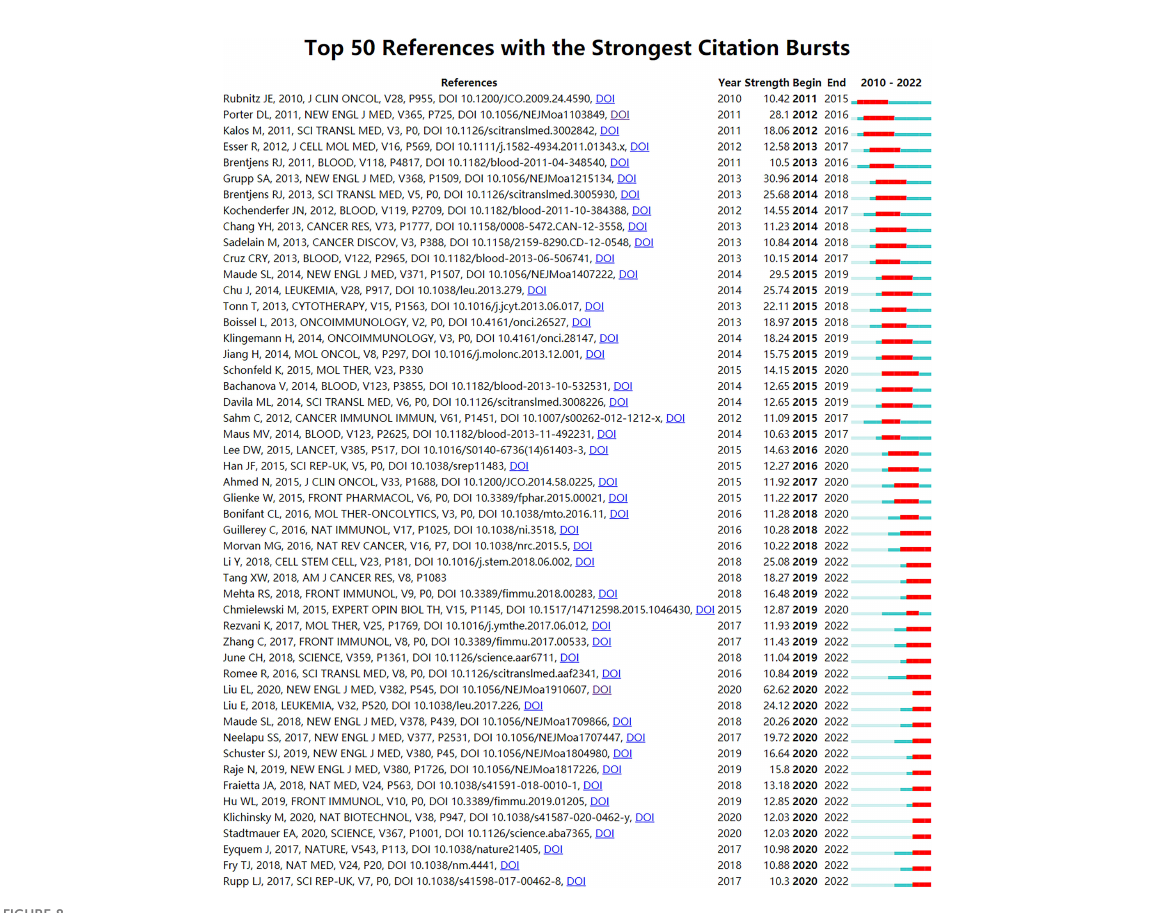
FIGURE 8 The top 50 references with the strongest citation bursts involved in CAR-NK cells. The Blue bars mean the reference had been published; the red bars mean citation